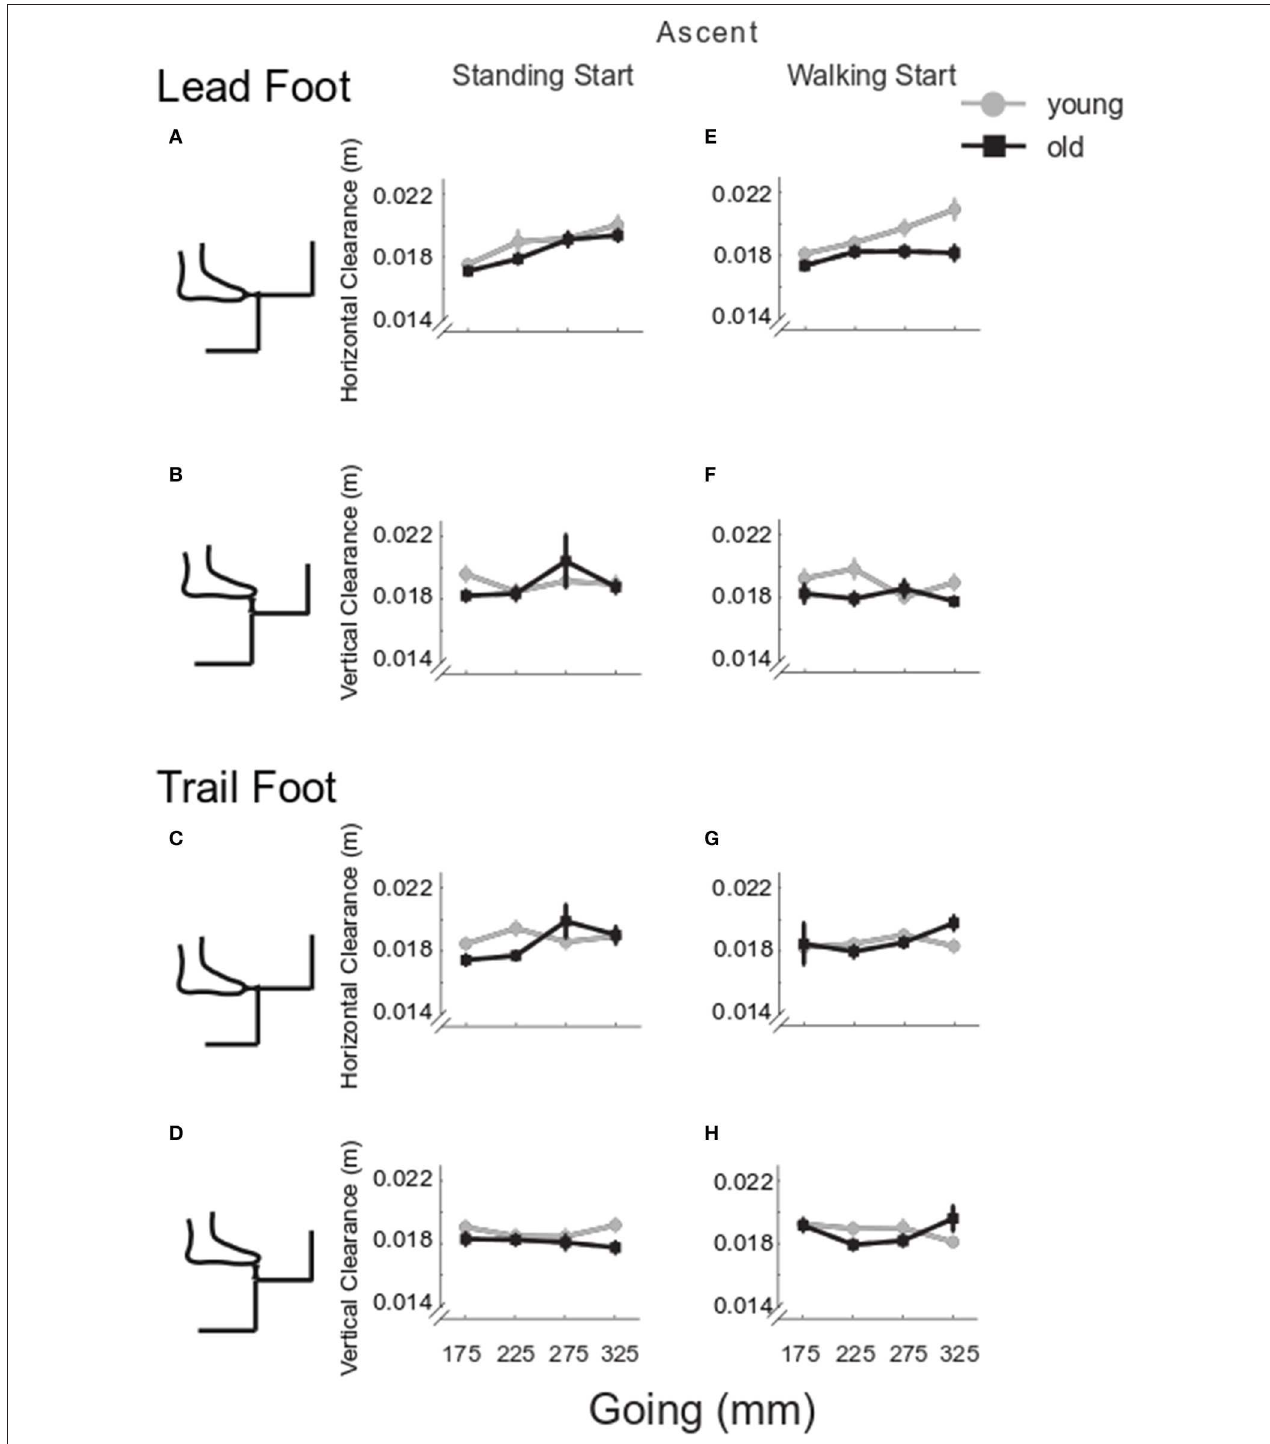
FIGURE 3 | Group clearance in ascent. The group mean and SE for older (black) and younger (gray) clearance in stair ascent was calculated in the horizontal direction (direction of travel) and in the vertical direction for lead and trail foot, at the four goings. The mean values were calculated whilst negotiating the stair from a standing start (left column) and from a walking start (right column). Lead foot clearance in horizontal (A,E) and vertical direction (B,F) ; trail foot clearance in horizontal (C,G) and vertical direction (D,H) .